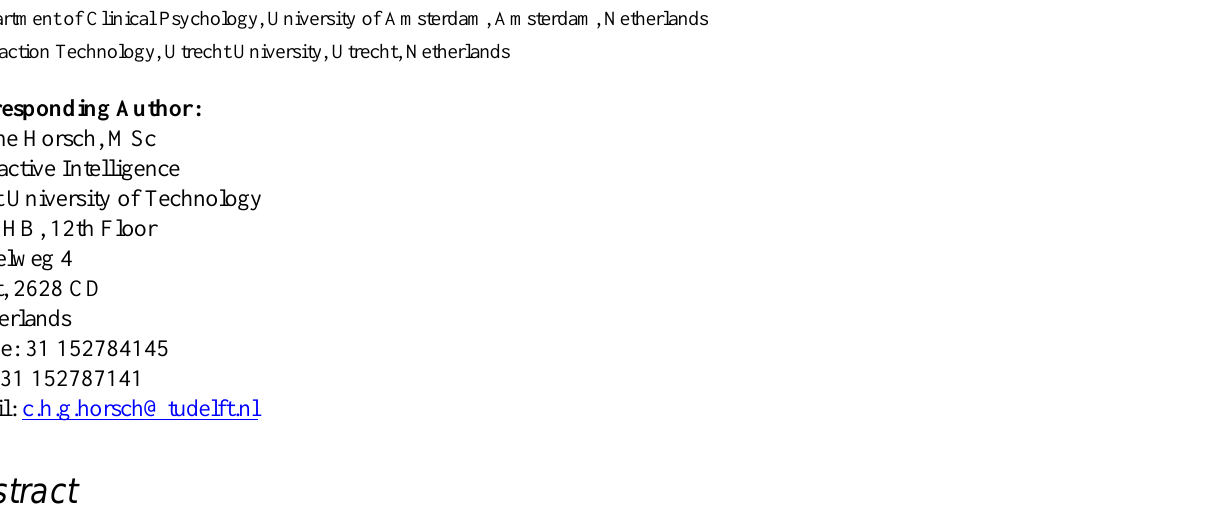
sleep initiation and maintenance disorders; patient compliance; meta-analysis; interview; focus groups; mobile apps; user-computer